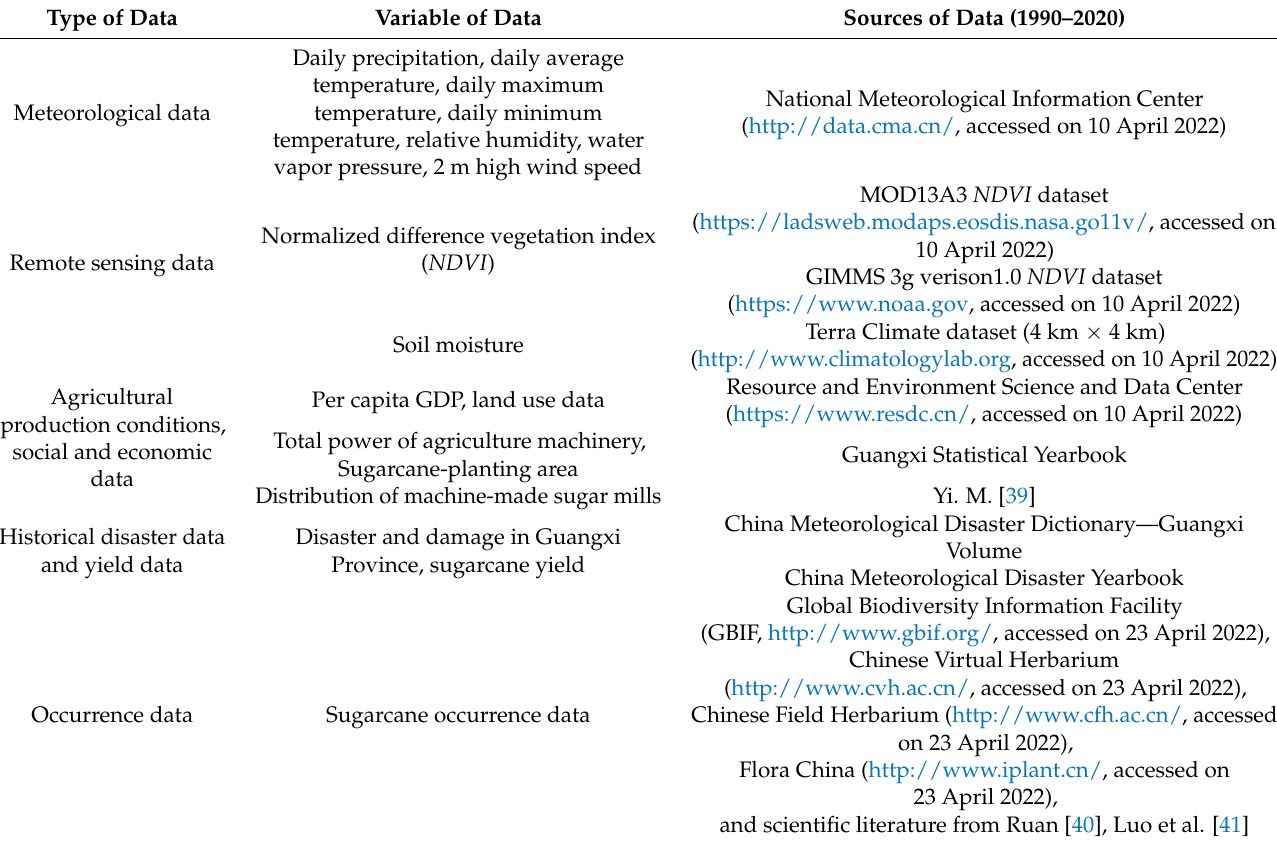
Table 1. Information on the data types and data sources used in the study.